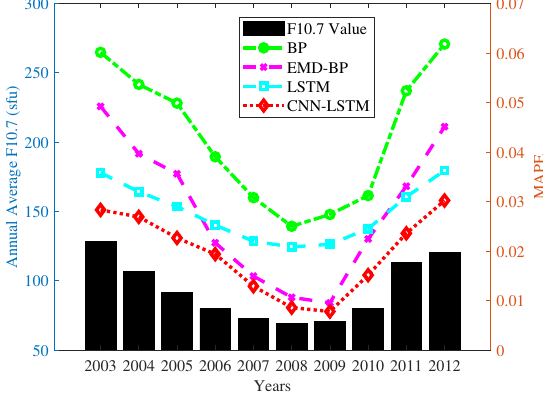
Figure 3. Distribution of Yearly MAPE in different